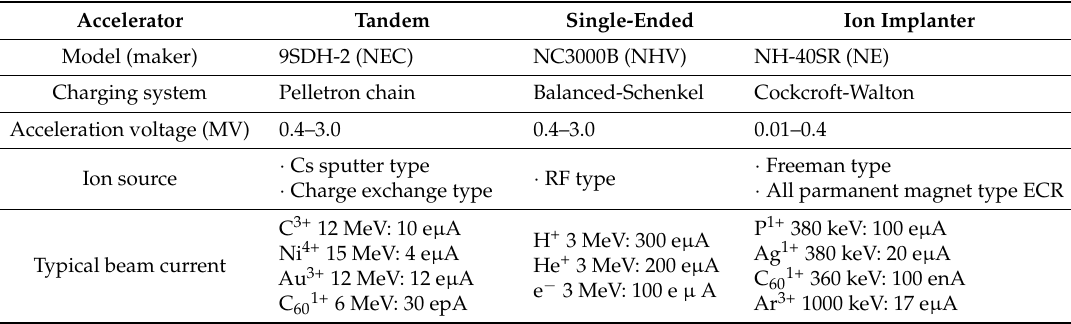
Table 5. Specifications of the electrostatic